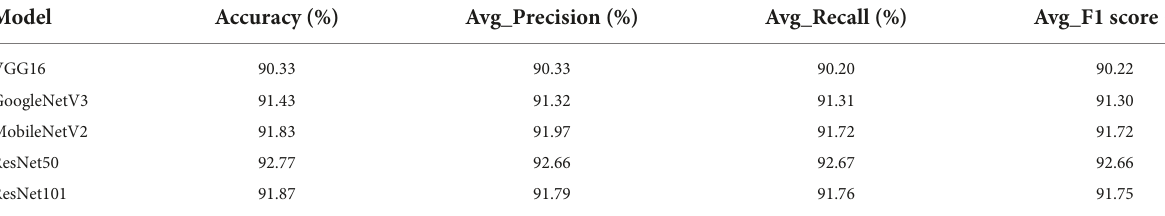
TABLE 8 Performance index of baseline models with tobacco shred images.